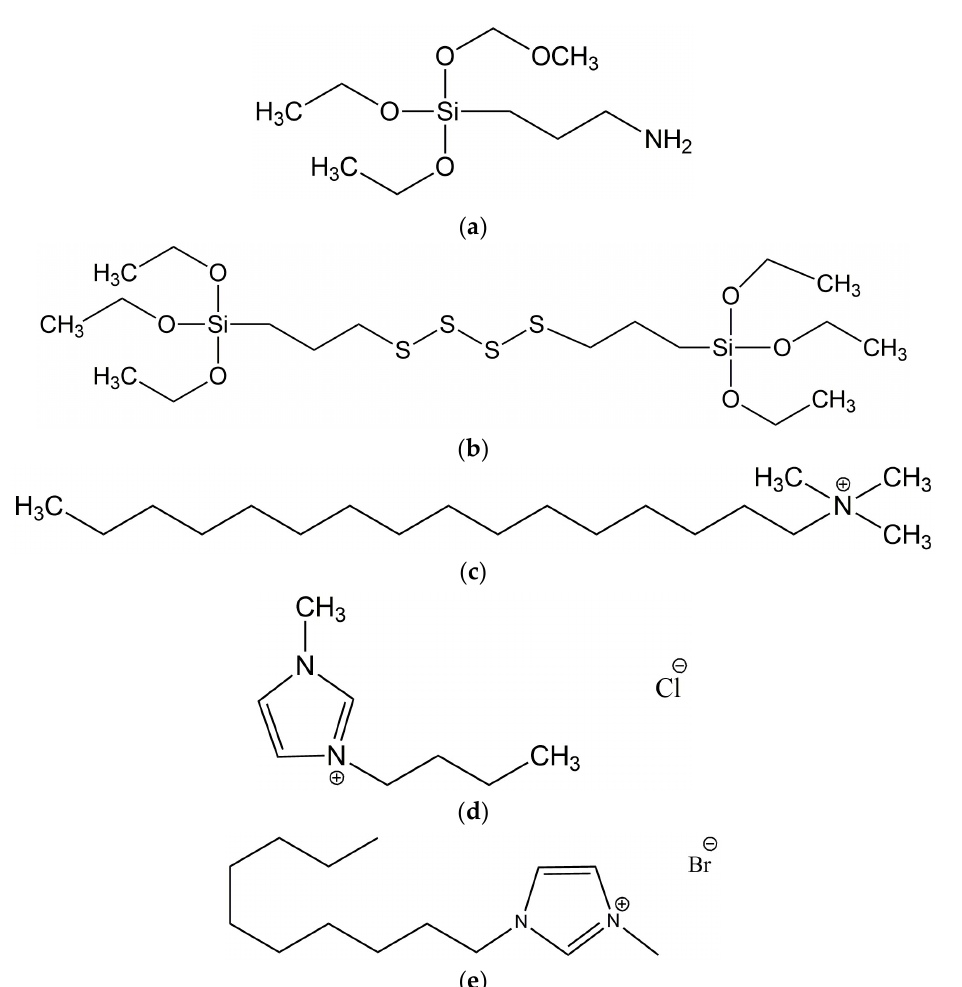
Figure 1. Structure of the additives employed to improve the dispersion degree of ground eggshells in the elastomer matrix: ( a ) (3-aminopropyl)-triethoxysilane, APTES; ( b ) bis[3-(triethoxysilyl)propyl] tetrasulfide, TESPTS; ( c ) cetyltrimethylammonium bromide, CTAB; ( d ) 1-butyl-3-methylimidazolium chloride, BmiCl; ( e ) 1-decyl-3-butylimidazolium bromide, DmiBr.